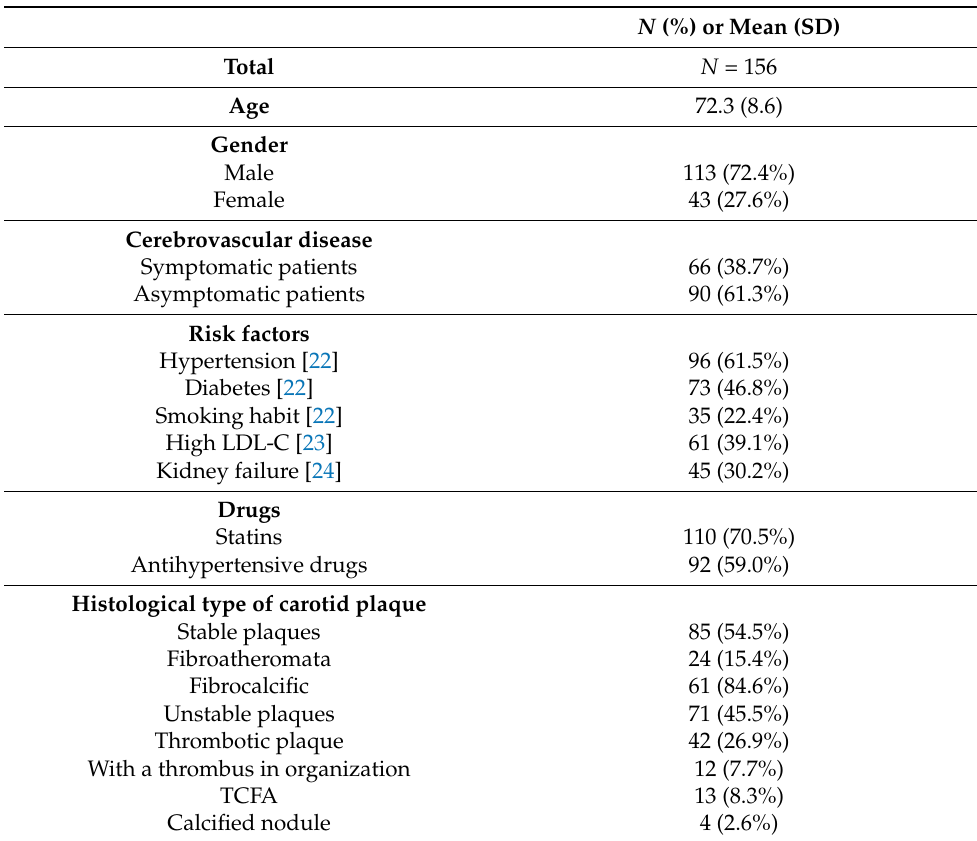
Table 1. Baseline characteristics of